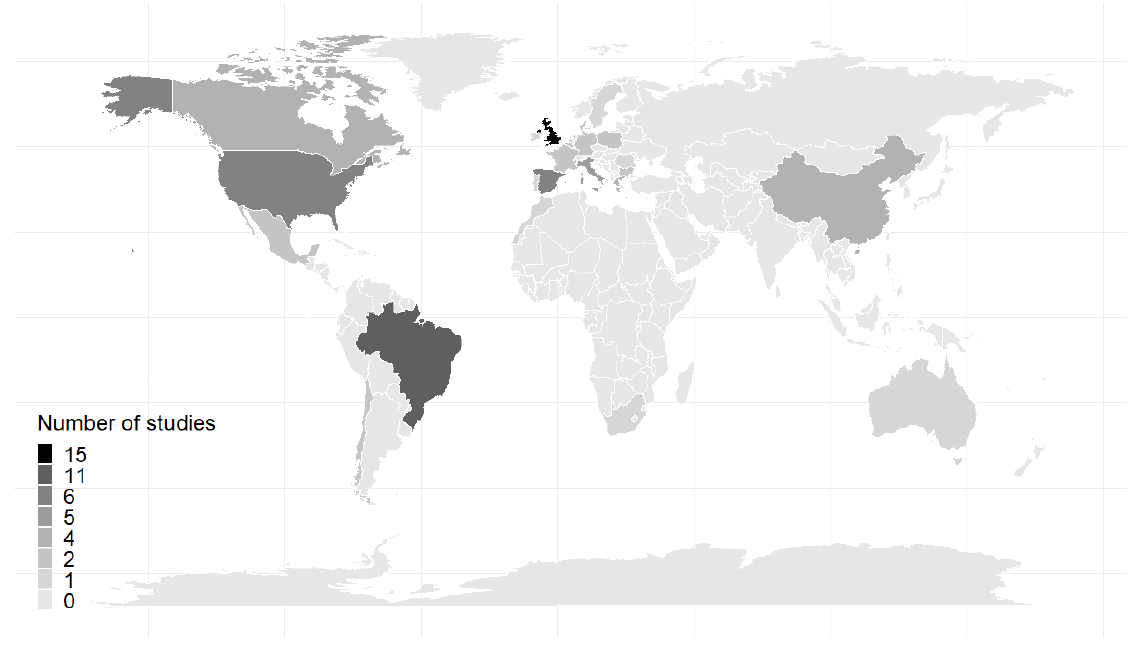
Figure 2. Number of studies focused on DHWC in social housing per location.